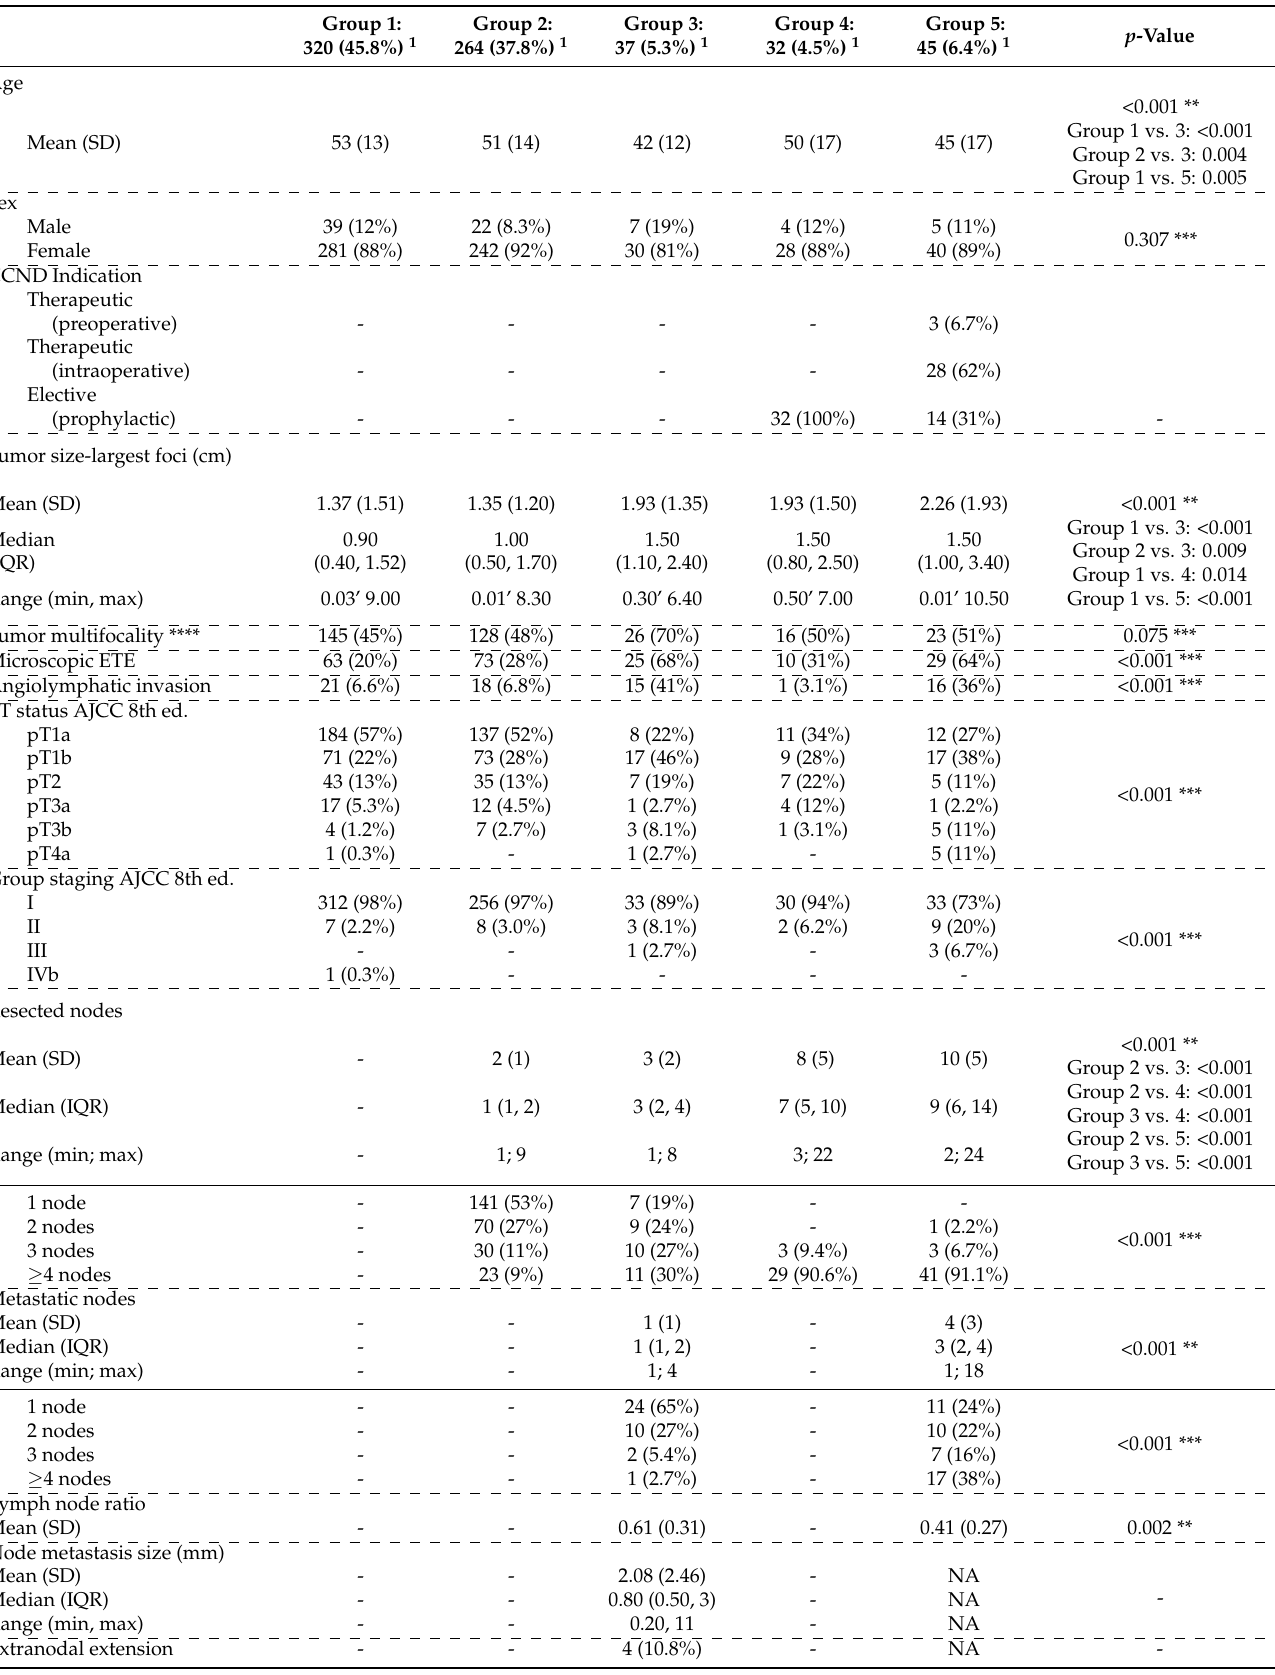
Table 1. Clinical-pathological characteristics of the patients included in the